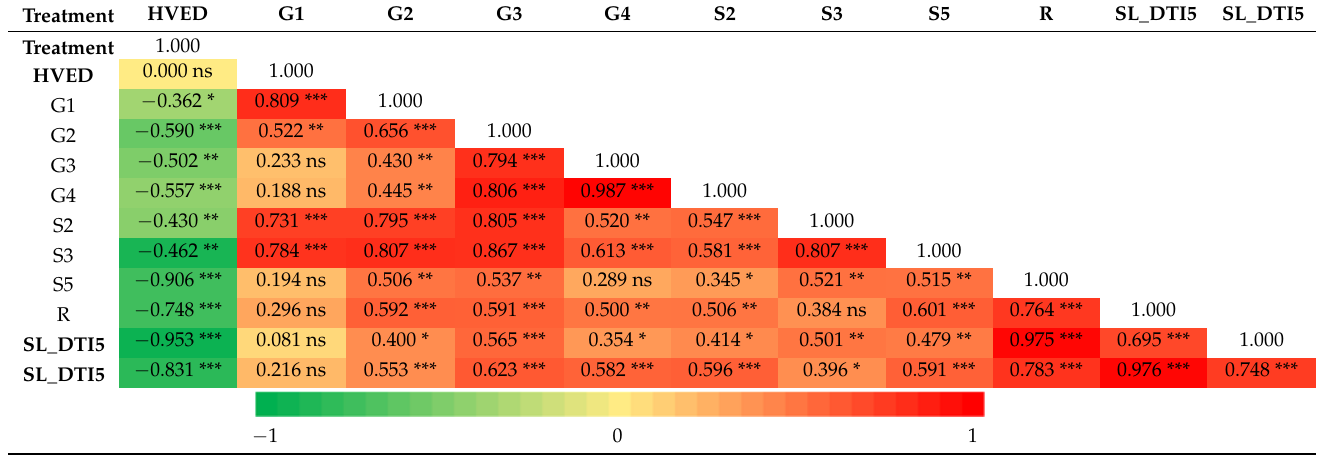
Table 7. Spearman’s correlation coefficients (r-values) among germination (G), shoot (S) and root (R) length, shoot length drought tolerance index (SL_DT), root length drought tolerance index (RL_DT) under drought treatments and high voltage electrical discharge (HVED) pretreatment (*, **, ***, significant at the 0.05, 0.01 and 0.001 levels). Numbers next to capital letters represent the treatment day.